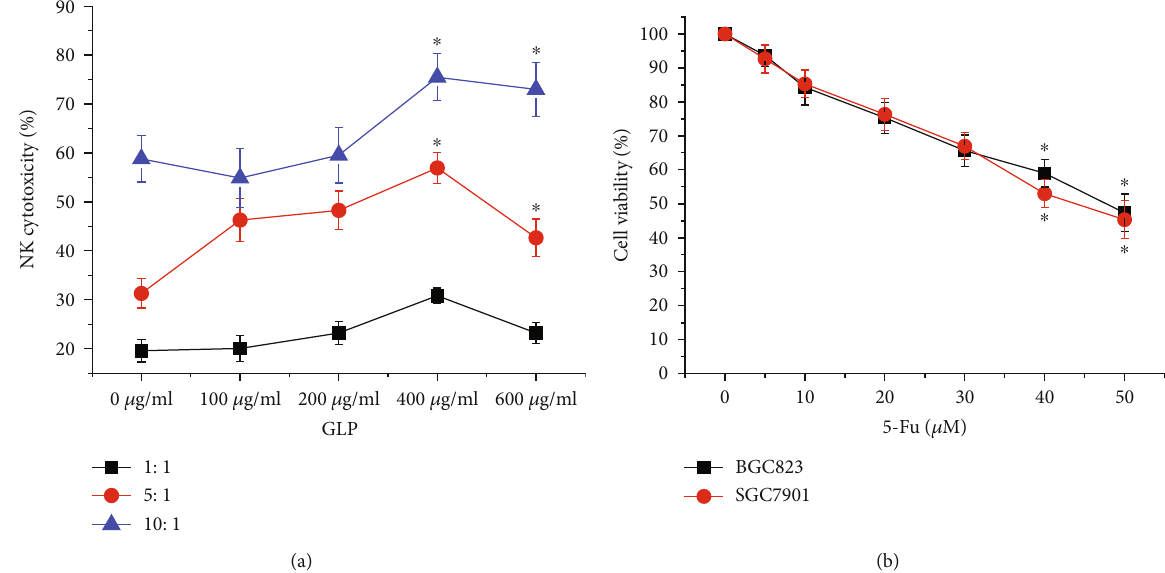
Figure 1: GLP directly enhanced the cytotoxicity of NK-92 cells. (a) GLP increased NK-92 cell cytotoxicity against BGC823 gastric cancer cells in a dose- and ratio-dependent manner. (b) CCK8 cell proliferation assay showed that 5-Fu had cytotoxic e ff ects on BGC823 and SGC7901 gastric cancer cells. Data were expressed as means ± SEM , and compared with the normal group, ∗ indicated p < 0 : 05 .